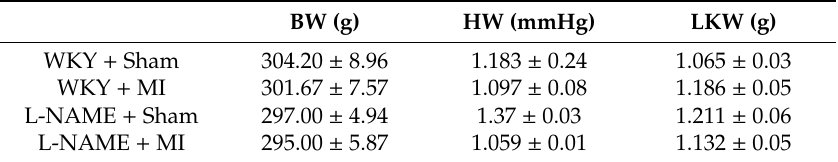
Table 2. Body weight (BW), heart weight (HW) and left kidney weight (LKW) of sham operated Wistar Kyoto rats (WKY + Sham); WKY rats with experimentally induced myocardial infarction (WKY + MI); sham operated WKY rats treated with L-NAME (20 mg / kg / day) (L-NAME + Sham) and L-NAME (20 mg / kg / day) treated WKY rats with experimentally induced myocardial infarction (L-NAME + MI); N = 6 in each group.